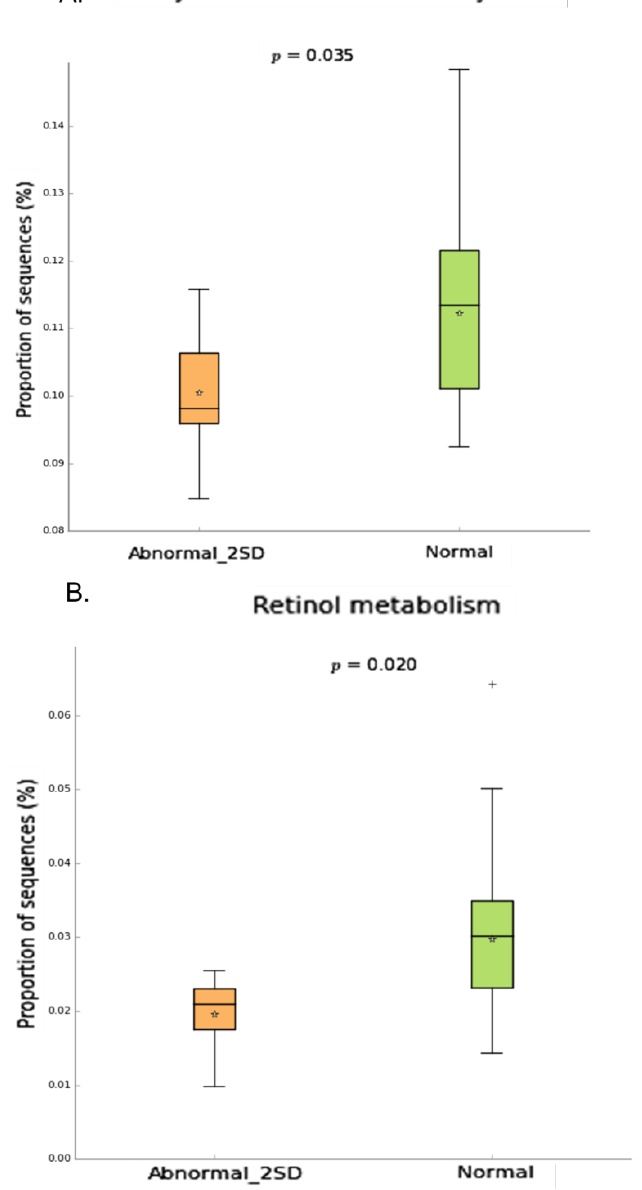
Figure 7. Inferred gut microbiome functions by PICRUSt from 16S rRNA gene sequences in neu- ropathy(2SD) compared to normal group. Difference in predicted functions of genes involved in ( A. ) biosynthesis of unsaturated fatty acids ( B. ) Retinol metabolism. (Mann-Whitney* p < 0.05;). Abbreviations: SD = Standard deviation.